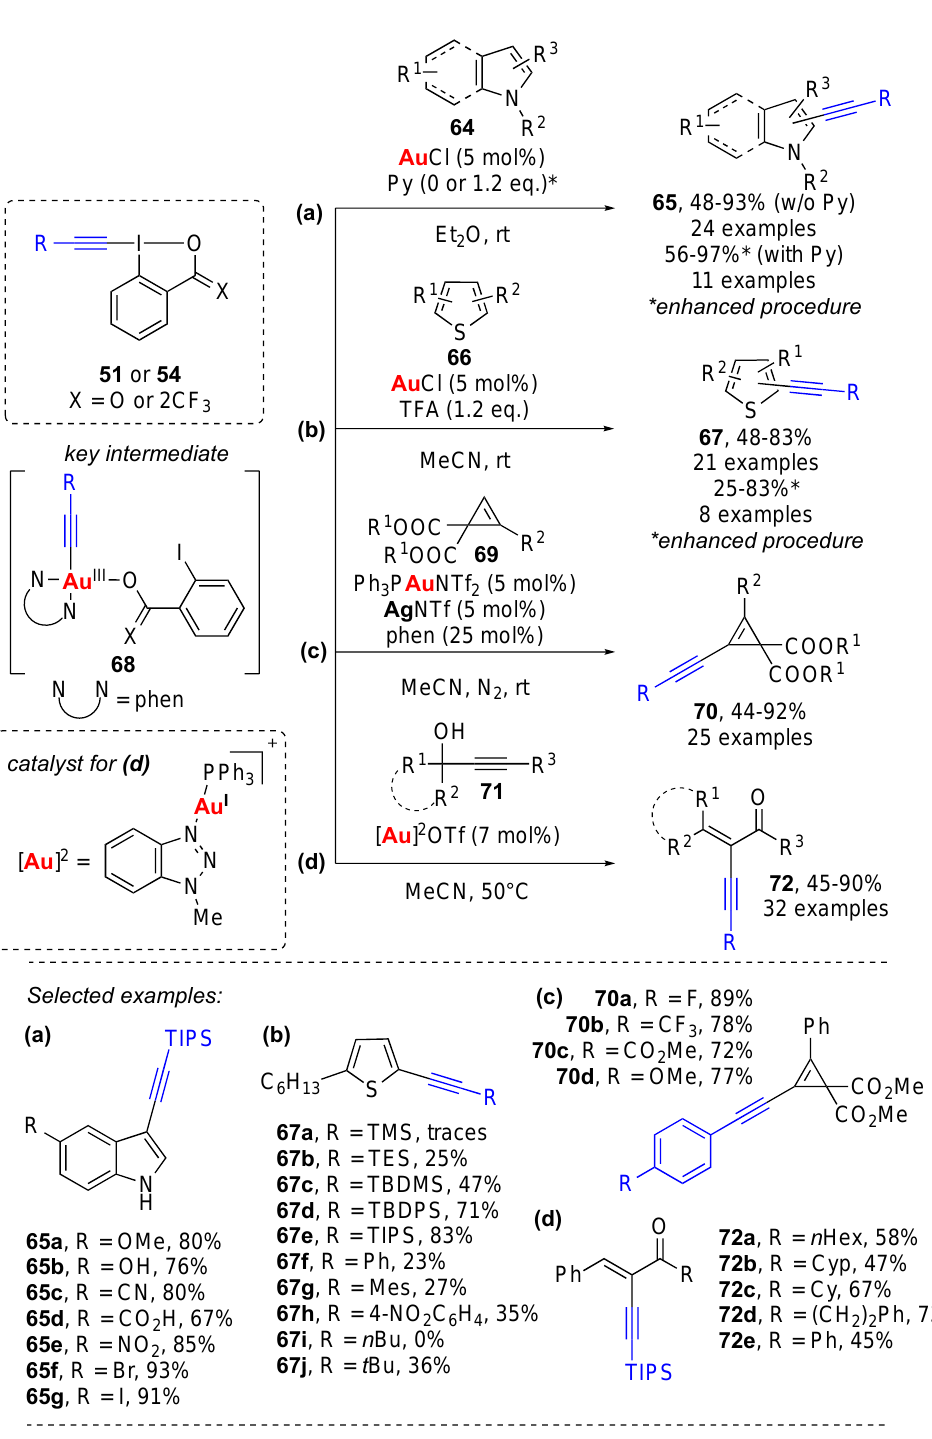
Scheme 15. Gold-catalyzed alkynylation reactions with the use of EBXs 51 and 54 . See explanation of reactions ( a – d ) in the text. Selected examples of products obtained in the reactions ( a – c ) are shown at the bottom of the